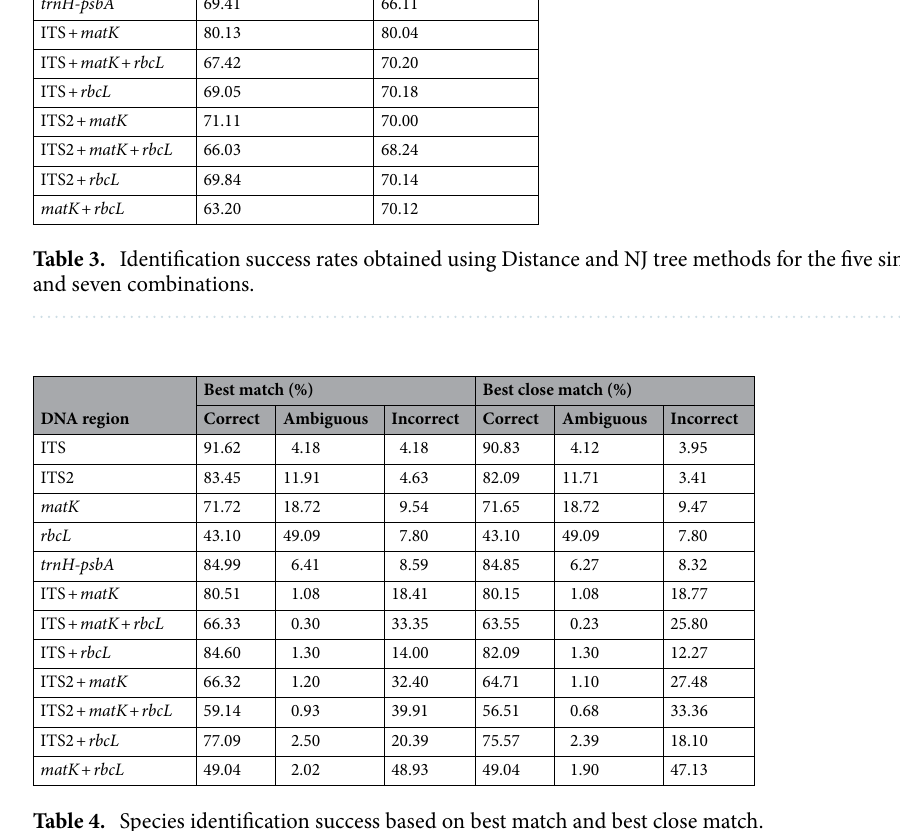
Table 4. Species identification success based on best match and best close match.